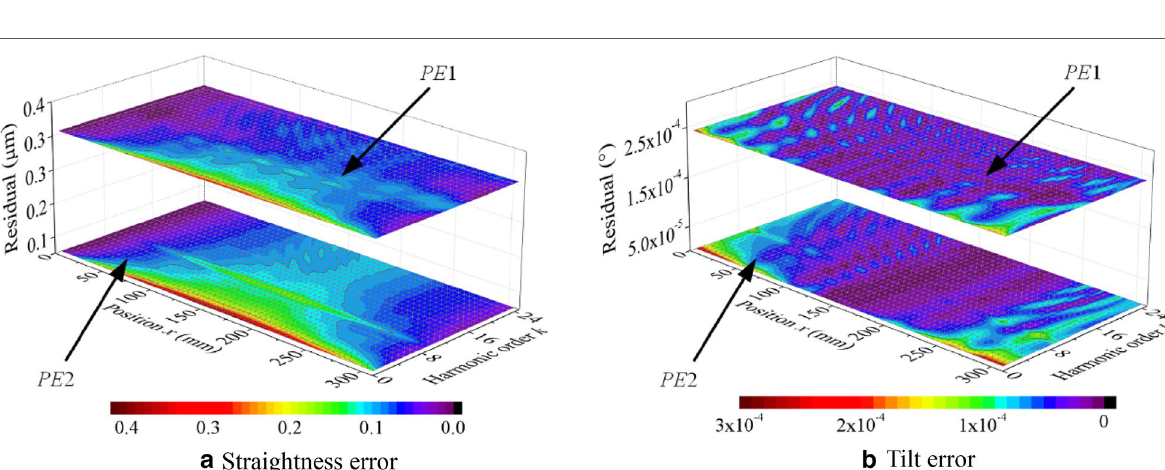
Figure 7 Relationships between the residuals caused by the positioning errors PE 1 and PE 2 at the sampling points and the harmonic order